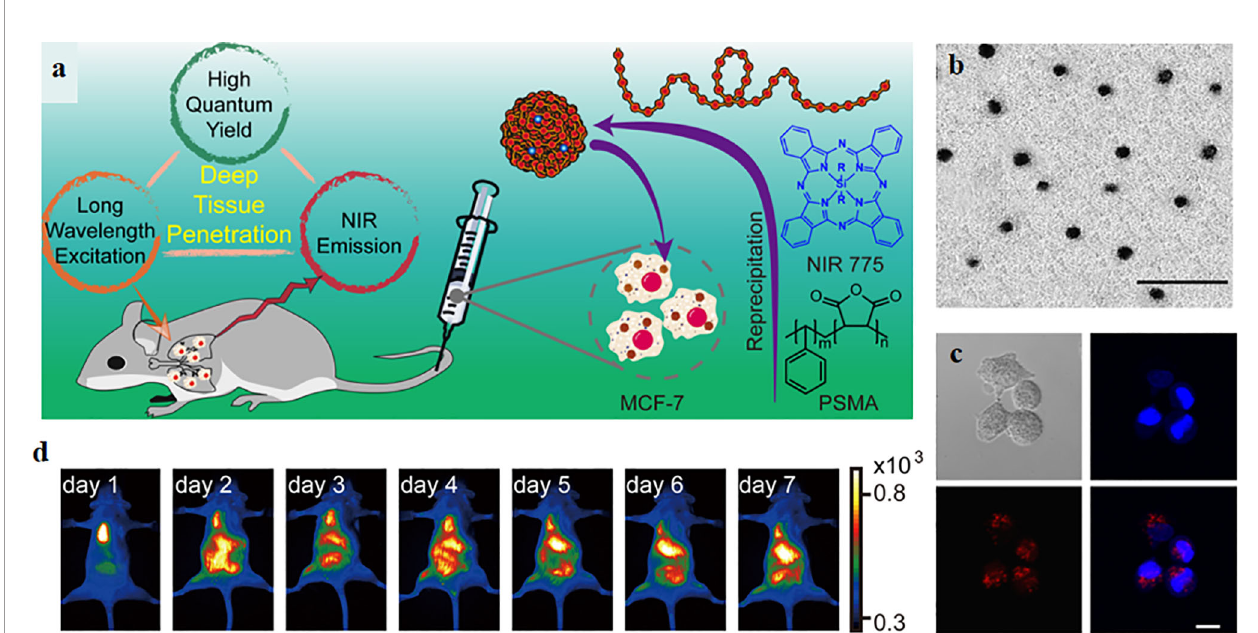
FIGURE 5 | (A) The schematic of synthetic R8-Pdots as imaging agents for whole-body cell tracking in deep organs. (B) The TEM image of Pdots, the scale bar is 100 nm. (C) Fluorescence imaging of MCF-7 cells labeled with R8-Pdots (red) and the cell nucleus was stained by Hoechst 33258. Scale bar: 20 m m. (D) Fluorescence imaging of the mouse in vivo (Zhang et al., 2018b) (with reproduction